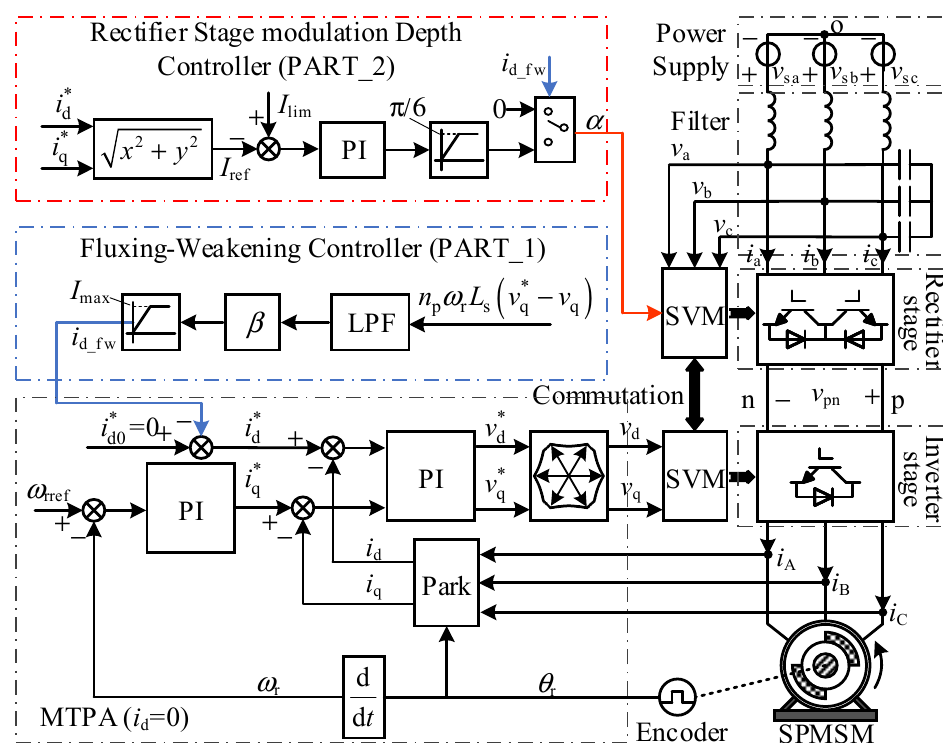
Figure 1. Structure diagram of the proposed wide speed range operation strategy for the indirect matrix converter–surface mounted permanent magnet synchronous motor drive (IMC-SPMSM). The speed regulation range of the proposed strategy is shown in Figure 2, where ω max1 , ω max2 , and ω max3 are the maximum operating speeds that can be achieved in different regions. Table 1 summarizes the control strategies and modulation methods that work in different regions (Y stands for working; q stands for range of VTR).